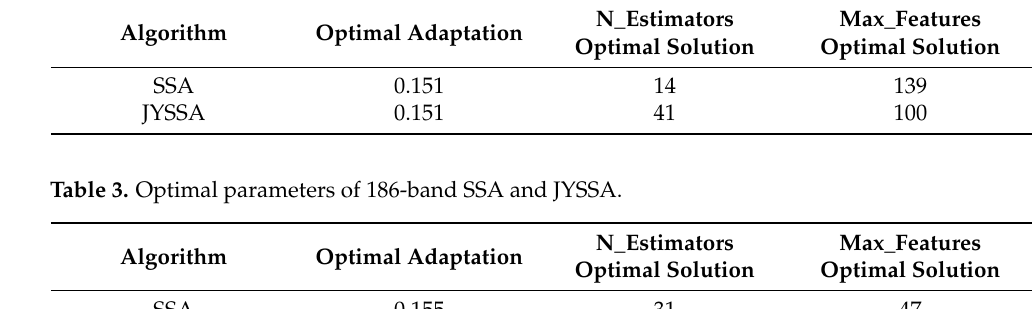
Table 2. Optimal parameters of 462-band SSA and JYSSA.